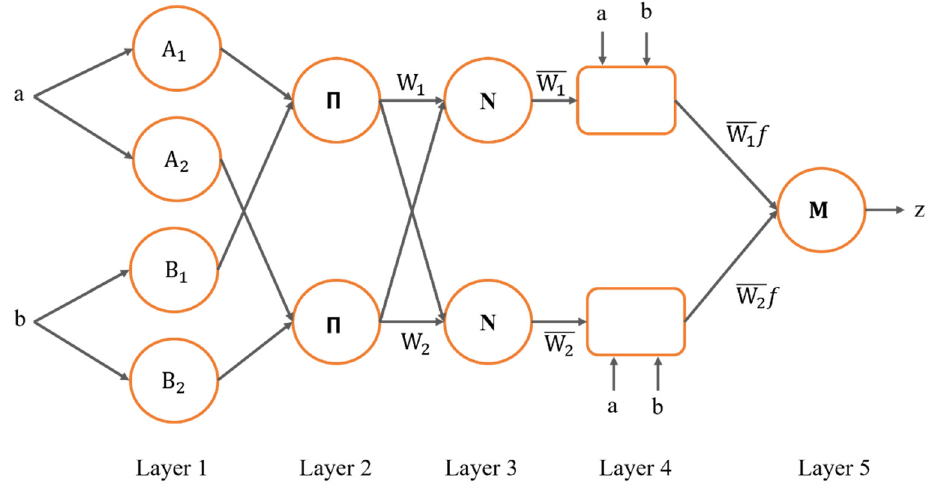
Figure 3. Adaptive neuro − fuzzy inference system (ANFIS) architecture.